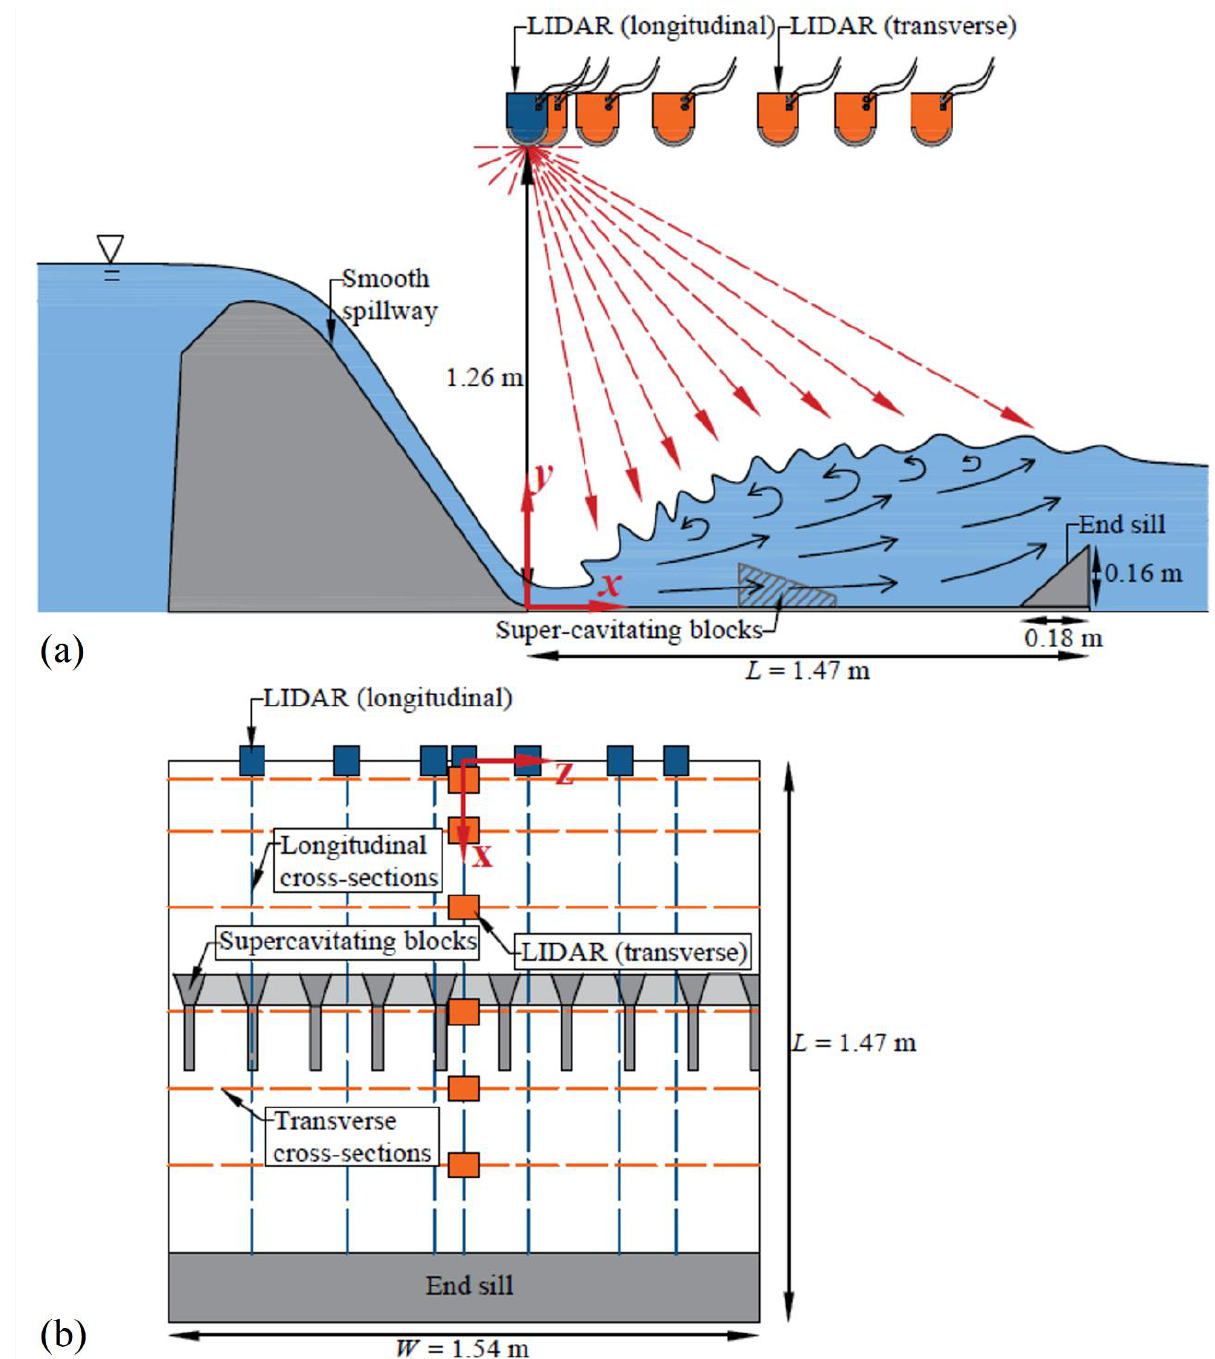
Figure 2. Stilling basin models and locations of LIDAR measurements: ( a ) side view (centerline); ( b ) top view.